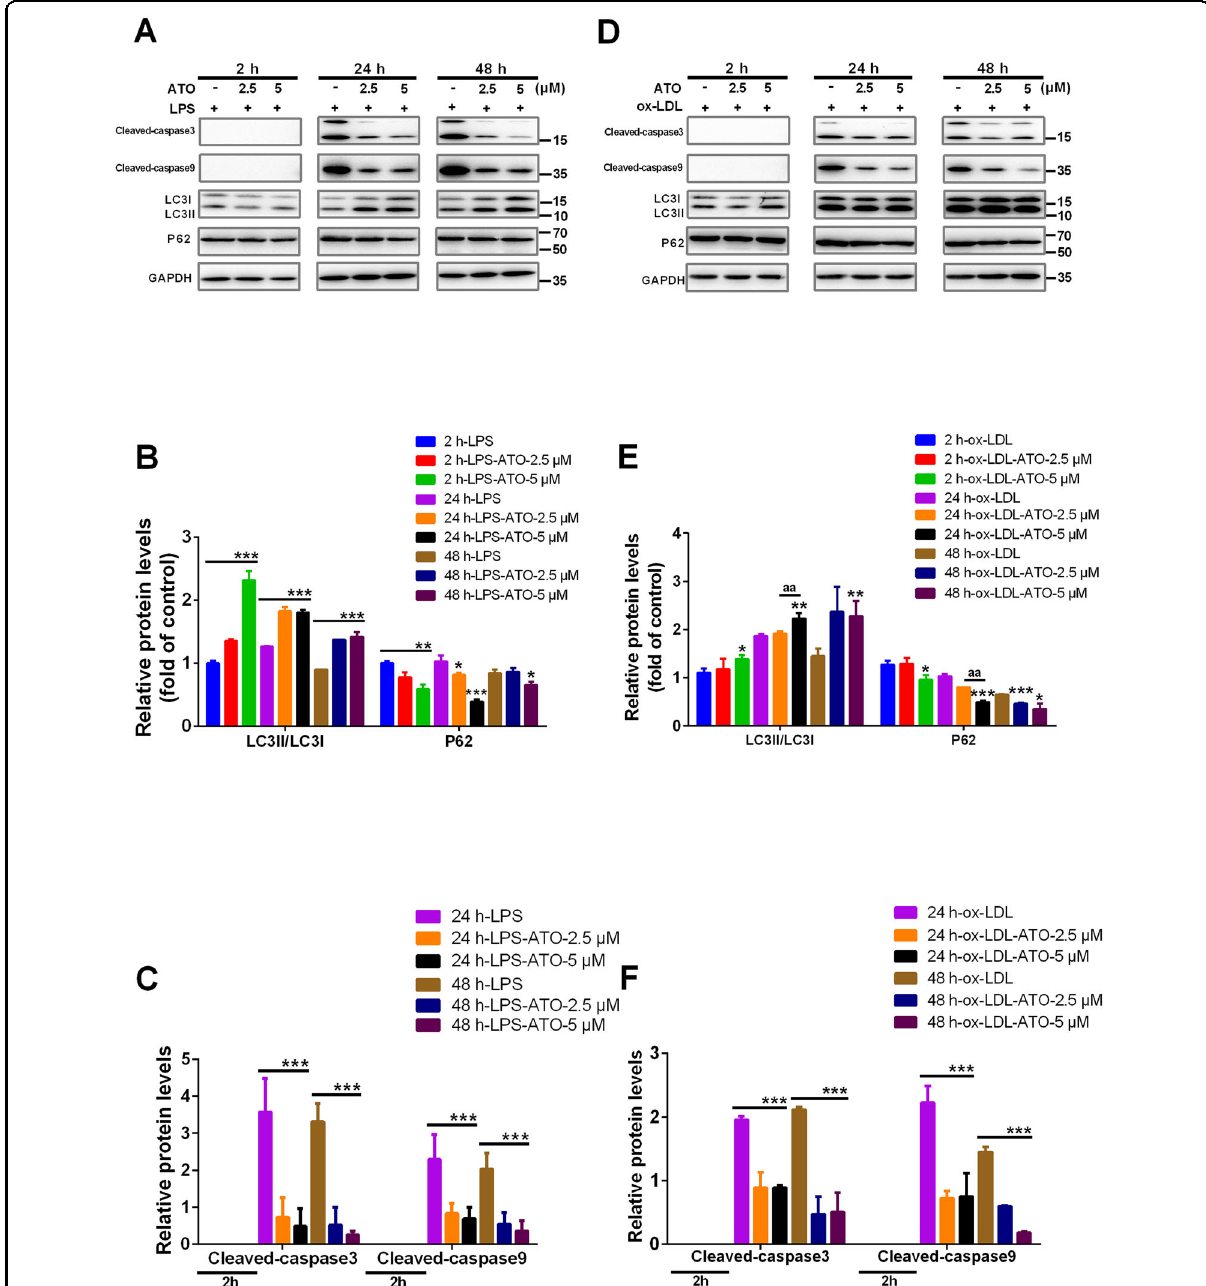
Fig. 2 ATO induce autophagy earlier than inhibiting the expression of apoptosis markers in macrophages and foam cells. A – C WB analysis of autophagy and apoptosis speci fi c proteins including LC3, P62, cleaved-caspase-3 and cleaved-caspase-9 in RAW264.7 cells after treatment with 100 ng/ml LPS for 6 h, followed by treatment with ATO (0, 2.5, 5 μ M) for 2, 24, or 48 h. * p < 0.05, ** p < 0.01, *** p < 0.001 vs. LPS group. D – F WB analysis of autophagy and apoptosis speci fi c proteins including LC3, P62, cleaved-caspase-3 and cleaved-caspase-9 in RAW264.7 cells after treated with 84 μ g/ml ox-LDL and ATO (0, 2.5, 5 μ M) for 2, 24, 48 h. Data were expressed as mean ± SD from 3 independent experiments. * p < 0.05, ** p < 0.01, *** p < 0.001 vs. ox-LDL group, aa p < 0.01 vs. Speci fi ed group, and ns means non-signi fi